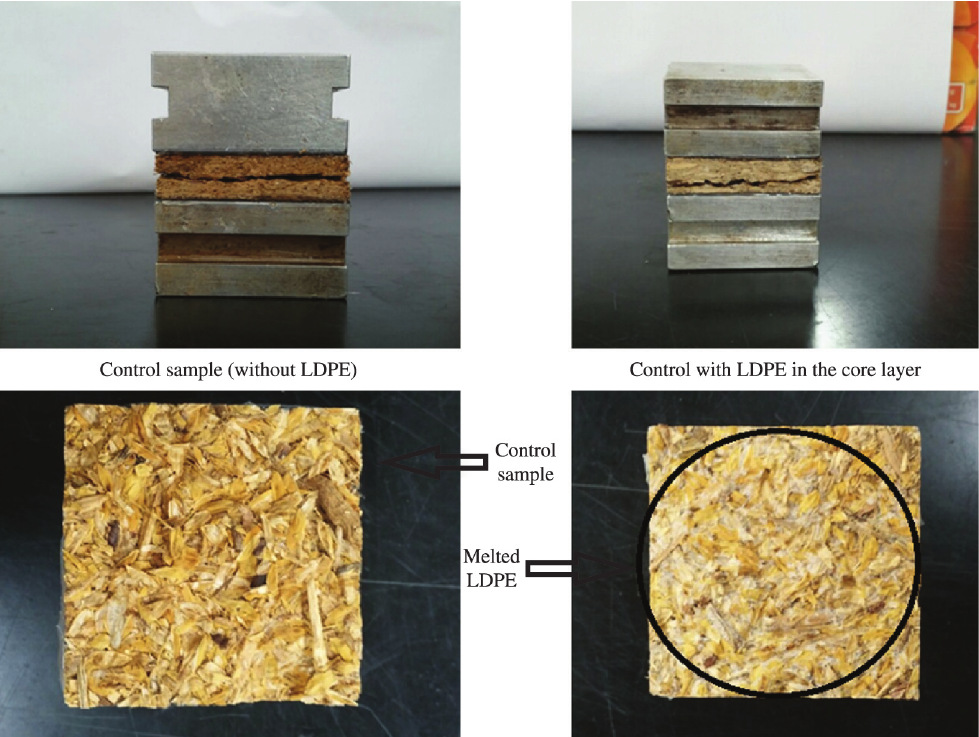
Figure 2. Fracture modes of the IB test samples with and without LDPE (top photos). The fracture surfaces of the IB test samples (below